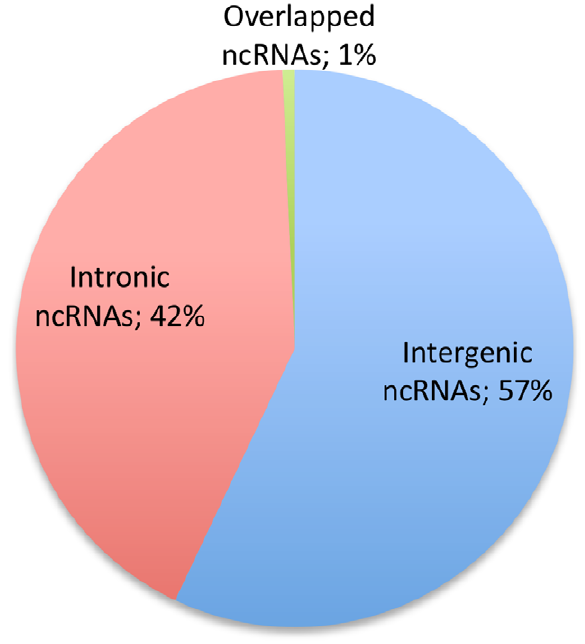
Figure 5. Relative abundance of the three main classifications of ncRNAs. Almost 60% of ncRNAs are long intergenic non-coding RNAs (intergenic ncRNAs).